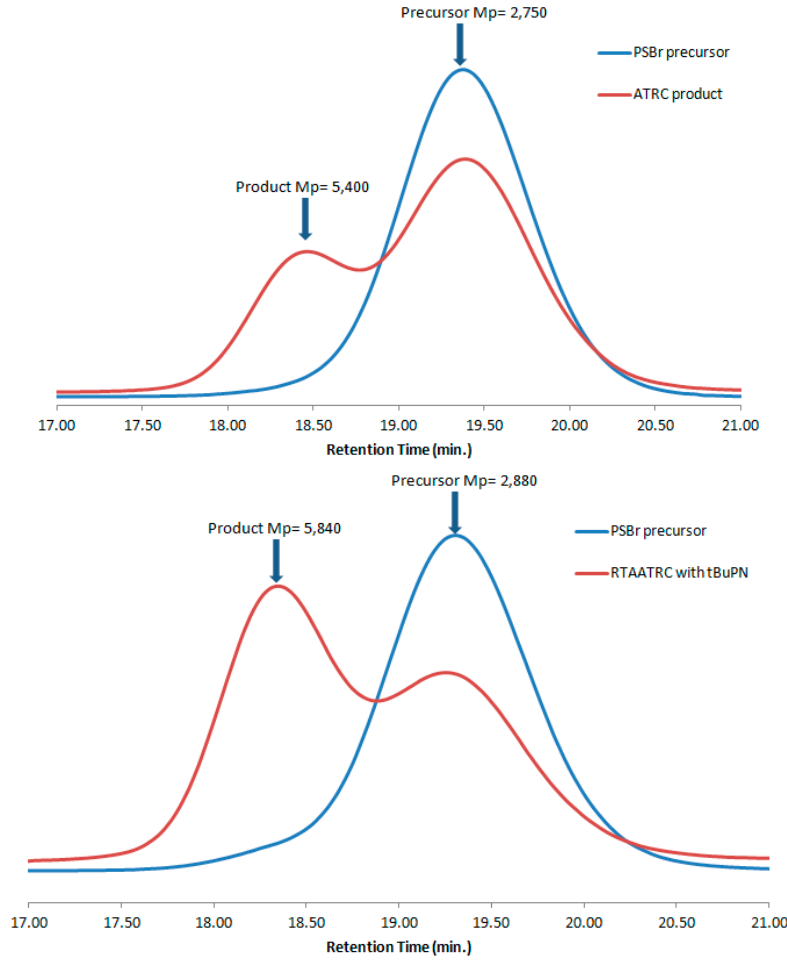
Figure 1. ( Top ) GPC traces of PSBr precursor (blue) and product of an ATRC reaction (red). ( Bottom ) GPC traces of PSBr precursor (blue) and product of RTA-ATRC reaction using N - tert -Butyl- α -phenylnitrone as the radical